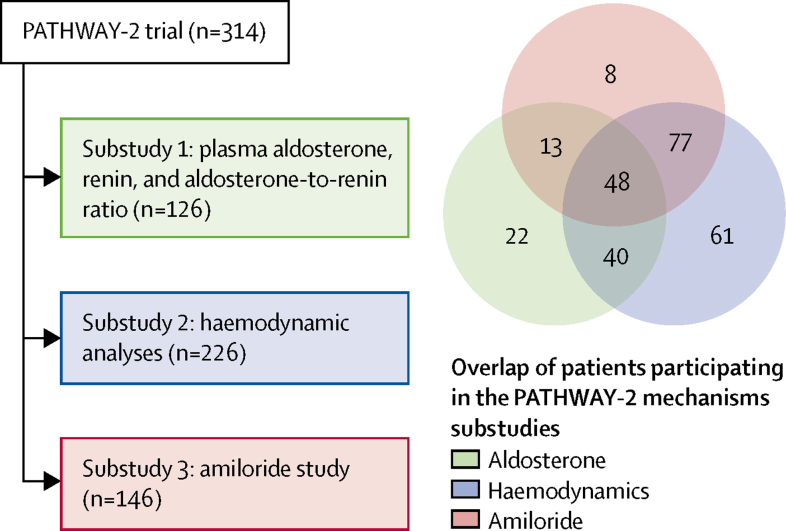
Participant numbers and measurements in the PATHWAY-2 mechanisms substudies